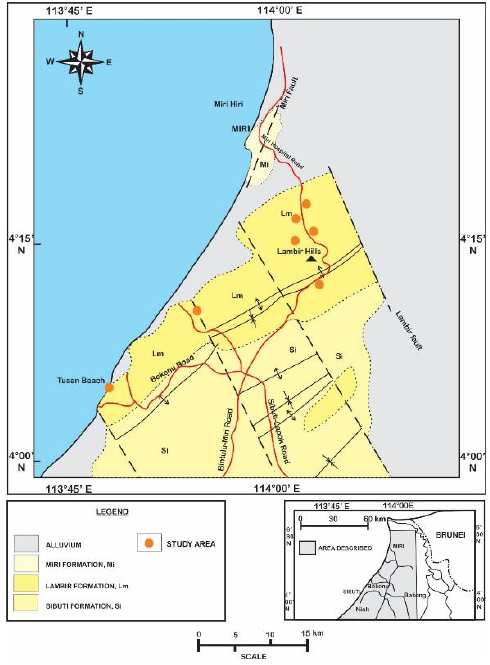
Figure 1: Map showing distribution of the Lambir Formation and